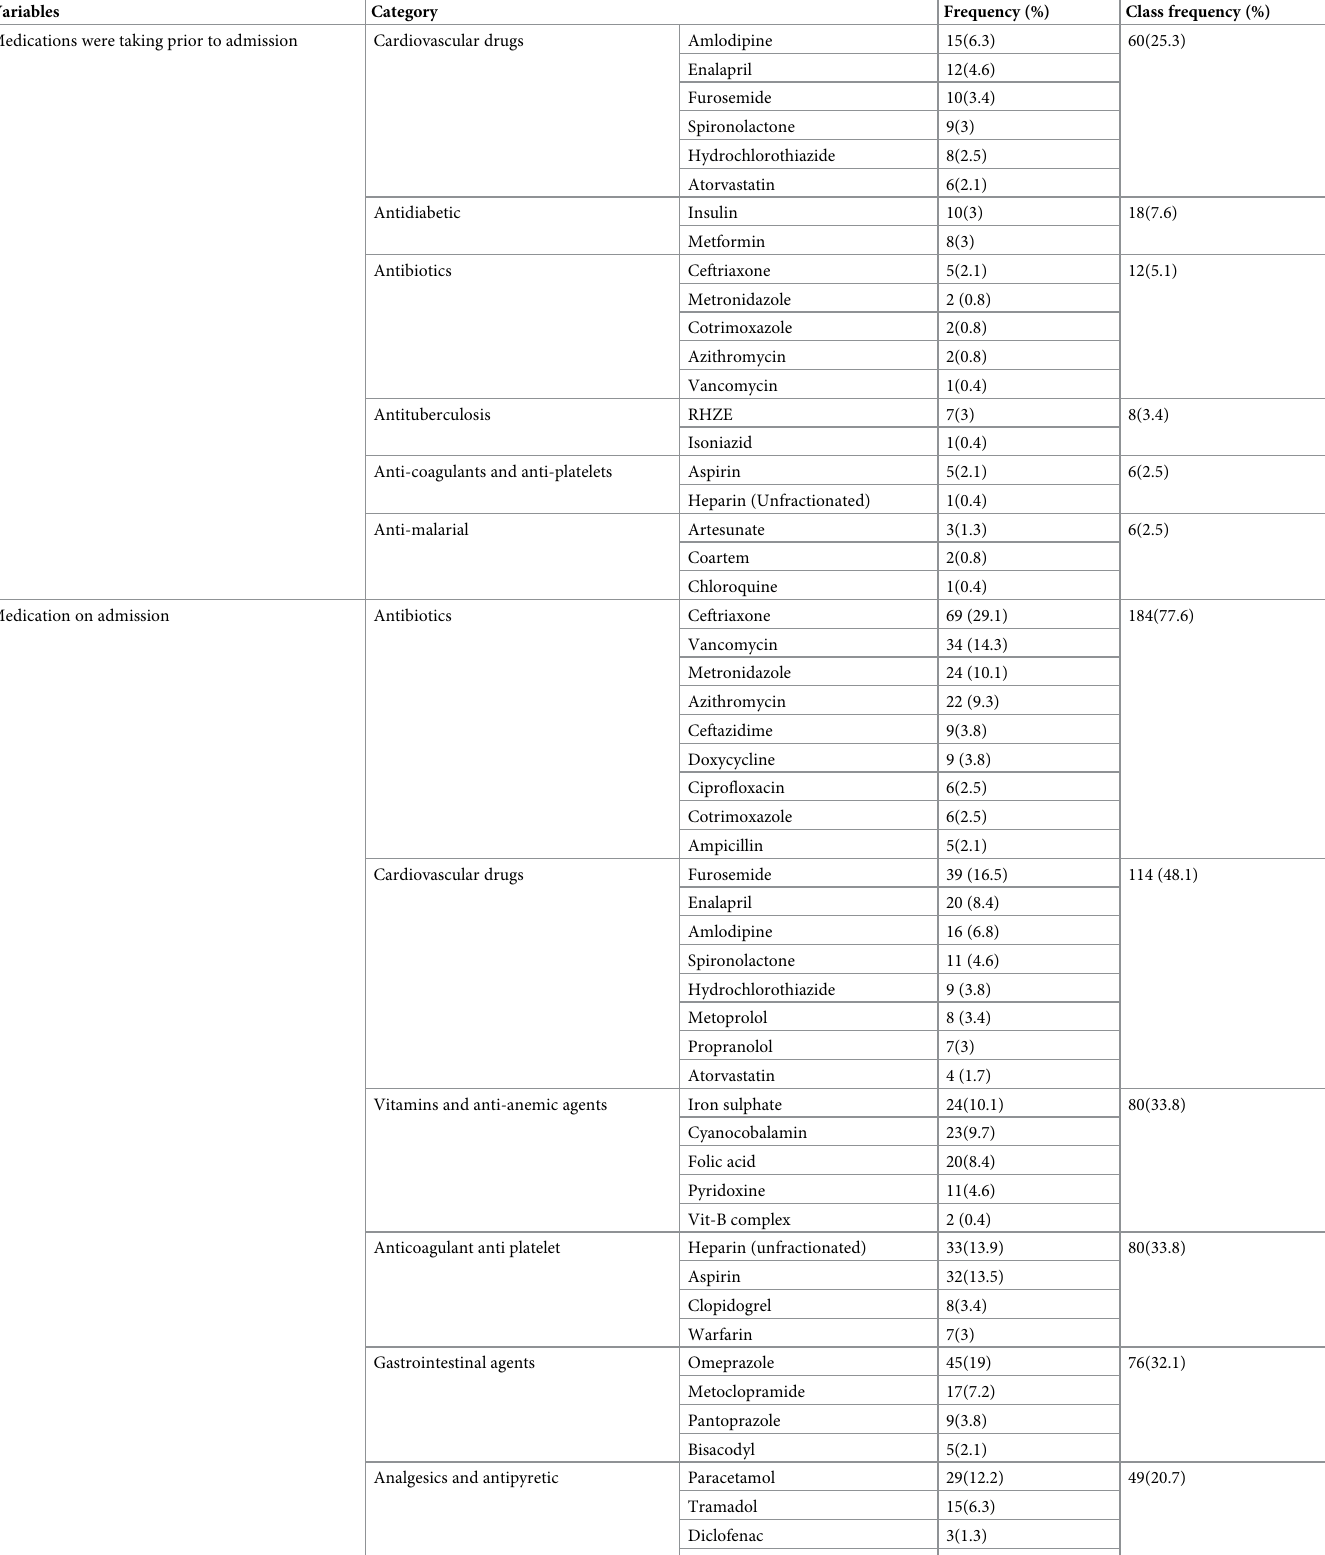
Table 4. Treatment pattern among hospitalized patients in the UoGCSH medical ward from May 28 to July 26, 2022 (N = 237).